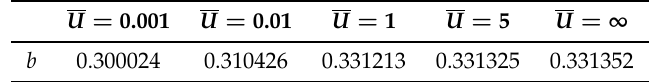
Table 3. Effect of U on the optimal debt ceiling b (*).